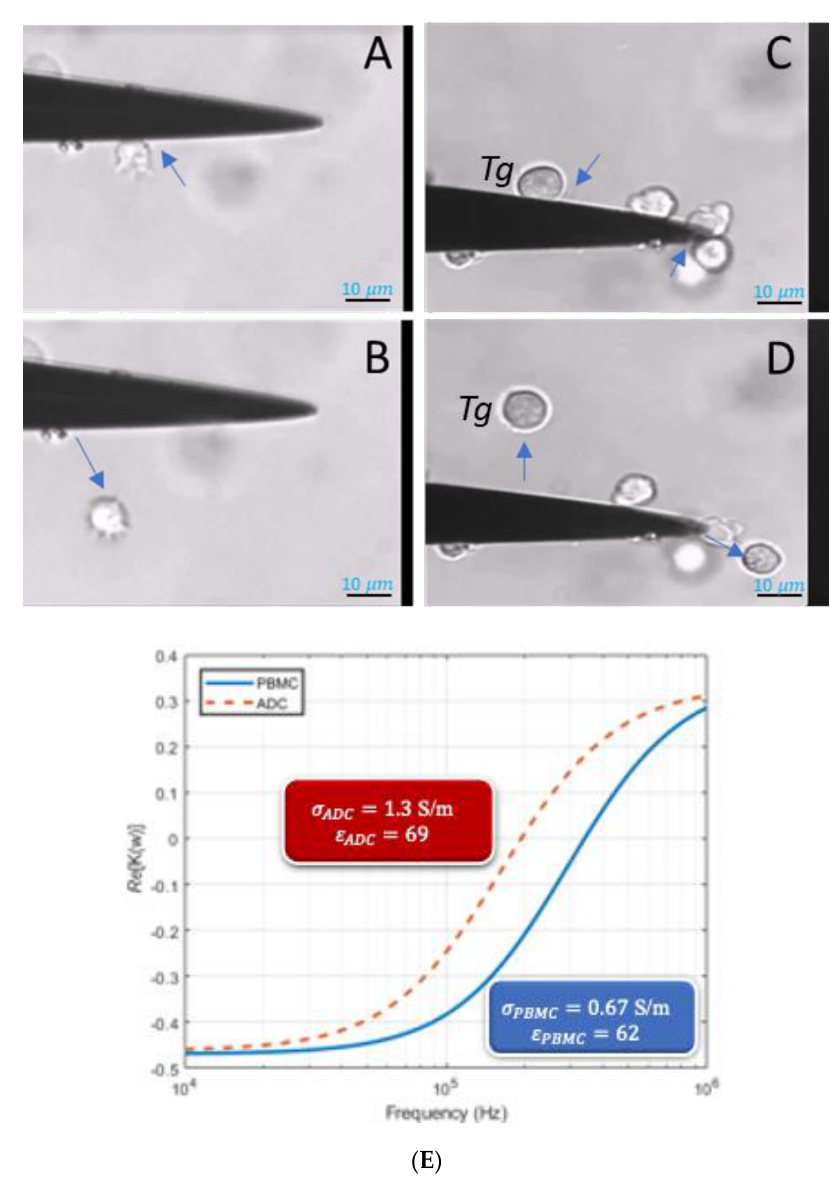
Figure 3. ADC cells experiencing DEP in the microwell at varying AC frequencies- ( A ) shows the ADC cells experiencing positive DEP (pDEP) wherein the cells move towards the high-field region or the triangular electrode in here and ( B ) shows the ADC cells experiencing nDEP behavior wherein the cells move away from the high field region. ( C ) and ( D ) are the images resulting from manual tracking of the target cell (labeled Tg) as demonstrated in [39]. ( E ) shows a plot of real part of Clausius-Mossotti factor varying with frequency (Hz). Here the cells initially experience nDEP (negative DEP) and as the frequency increases, they switch to pDEP (positive DEP) where the switch is termed as first crossover frequency.